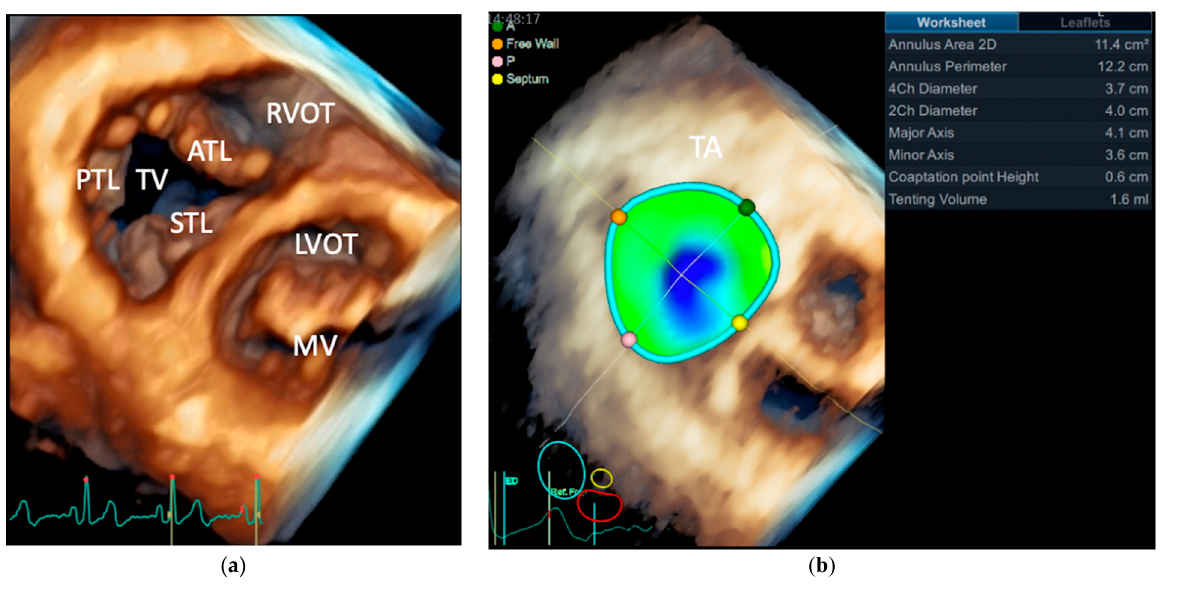
Figure 1. Transthoracic 3DE volume rendering of the tricuspid valve. ( a ) Anatomy of the tricuspid valve seen from the ventricular perspective and its relationships with adjacent structures; ( b ) Quantitative assessment of the tricuspid annulus. The colored dots on the annulus are used for anatomic orientation. Abbreviations: 2Ch, 2-chamber view; 2D, two-dimensional echocardiography; 3DE, three-dimensional echocardiography; 4Ch, 4-chamber view; A, anterior; ATL, anterior tricuspid leaflet; LVOT, left ventricular outflow tract; MV, mitral valve; P, posterior; PTL, posterior tricuspid leaflet; RVOT, right ventricular outflow tract; STL, septal tricuspid leaflet; TA, tricuspid annulus; TV, tricuspid